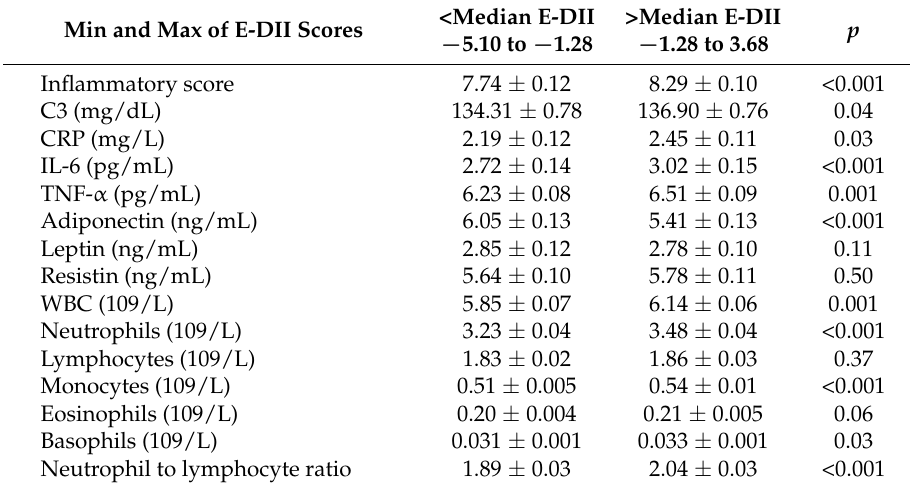
Table 4. Inflammatory profiles of the study population ( n = 1992) according to dietary inflammation status. Min and Max of E-DII